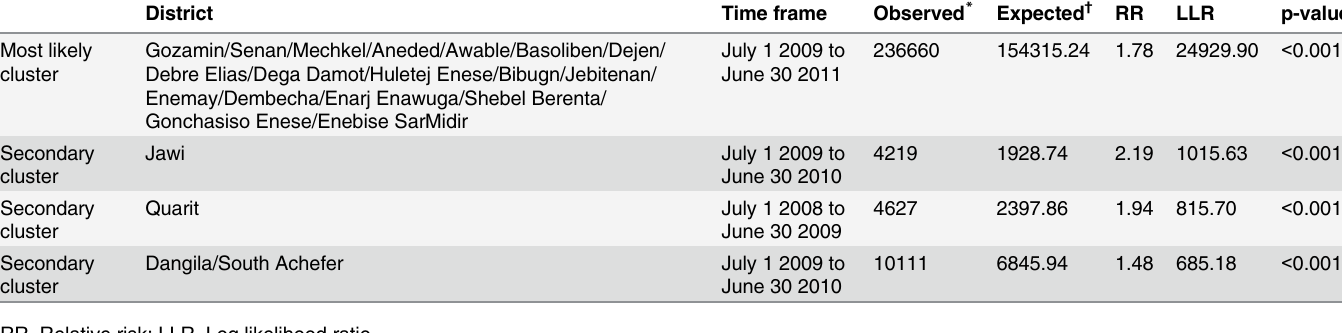
Table 3. Spatiotemporal clusters of childhood diarrhea in northwest Ethiopia between 1 July 2007 and 30 June 2014. District Time